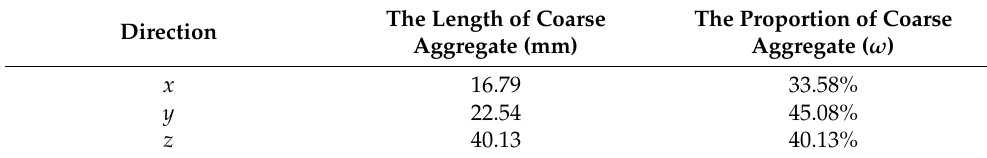
Figure 10. Schematic diagram of marking the length of coarse aggregate on ultrasonic measuring line (mm). The proportion of coarse aggregate on the ultrasonic survey line was obtained as shown in Table 6 Table 6. The proportion of coarse aggregate on the ultrasonic survey line.